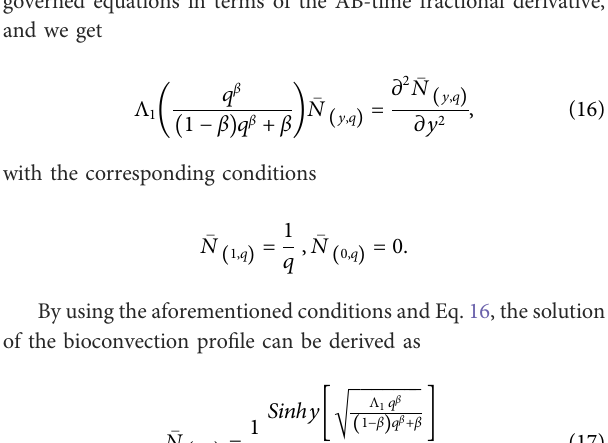
and the LT of the CF-fractional derivative is